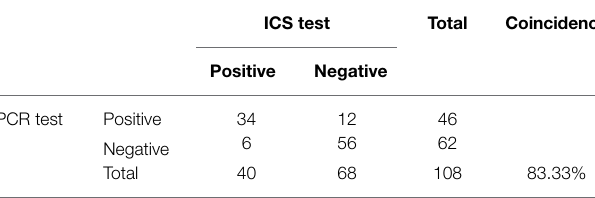
TABLE 3 | Results of the detection of PRRSV in clinical samples via ICS and PCR.